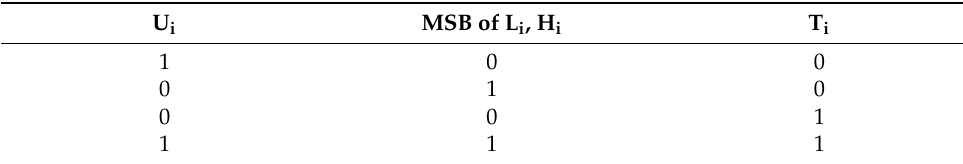
Table 2. Mapping rule of extraction procedure.